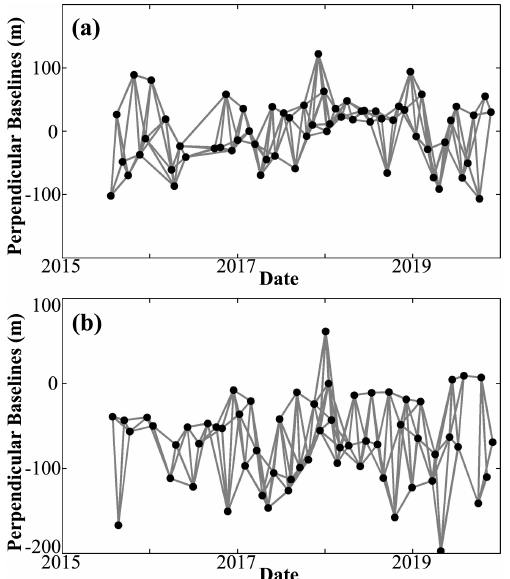
Figure 2. Connected network of interferograms for (a) S1-40 and (b) S1-142 datasets. Black dots and grey lines denote the Sentinel-1 acquisitions and interferograms,